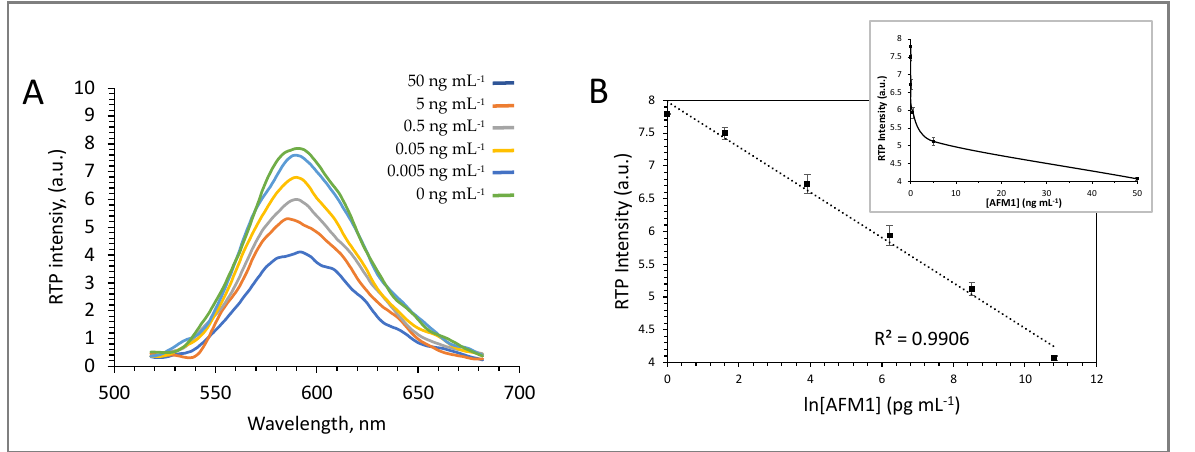
Figure 5. ( A ) RTP spectra obtained for the AFM1 concentrations assayed; ( B ) Immunoassay response curve linearized by applying ln to the x-axis at different AFM1 concentrations. Inset: non-linearized immunoassay response curve .